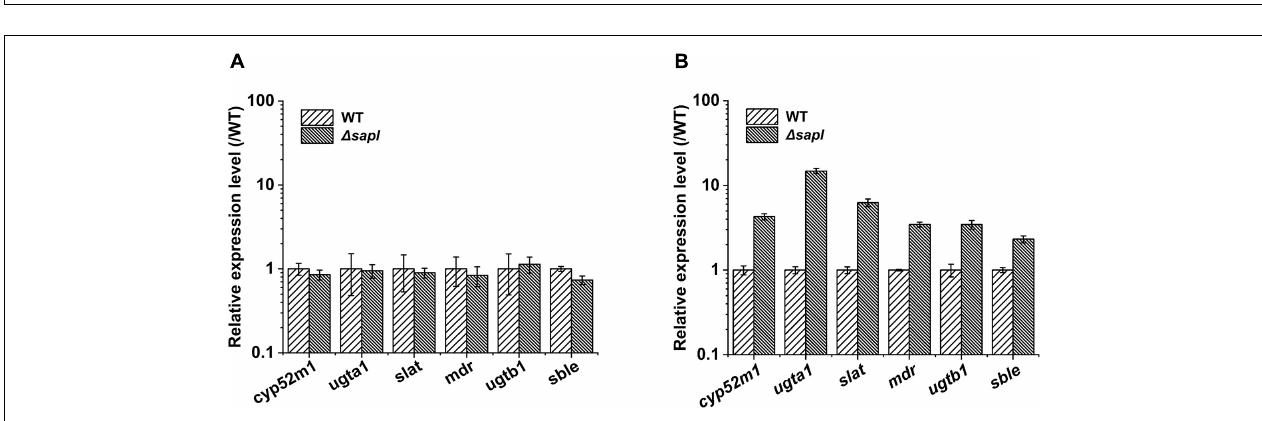
FIGURE 5 | The different transcriptional levels of the key genes for SLs synthesis. (A) The yeast extract used as nitrogen source (WT, wild-type strain). (B) The ammonium sulfate used as nitrogen source (WT, wild-type strain).